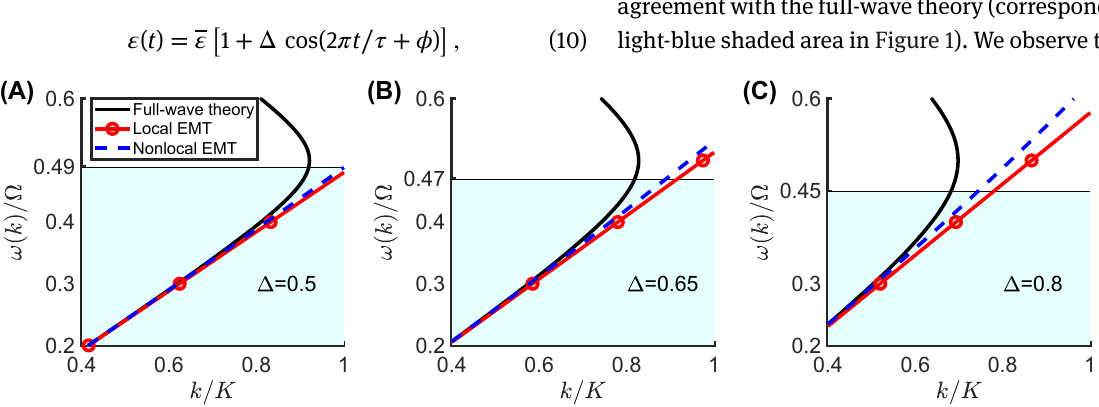
Figure 1: Comparison between the predictions from the full-wave theory and both local an nonlocal EMT models for a temporal metamaterial with relative permittivity as in Eq. (10), with 𝜀 = 5. (A)–(C) Normalized angular frequency 𝜔 ∕Ω as function of the normalized wavenumber k ∕ K , for Δ = 0 . 5 , 0 . 65, and 0.8, respectively.The light-blue shaded area indicates the region where the nonlocal EMT works well ( ≲ 10 % error with respect to full-wave